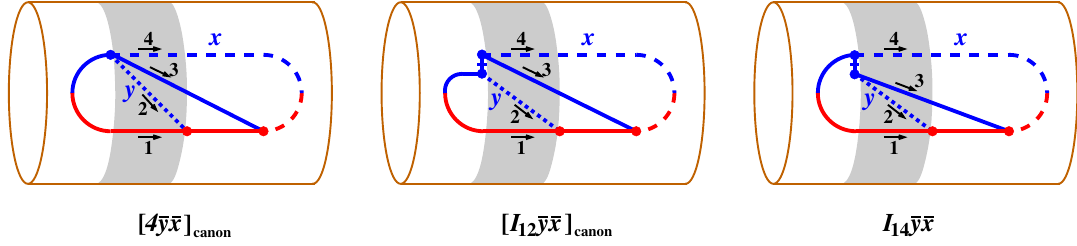
Figure 11 . Like figure 10b but here including all instantaneous diagrams that contribute to the canonical routing (1234) and so to [ d Γ /dx dy ] canon 4¯ y ¯ x diagram,